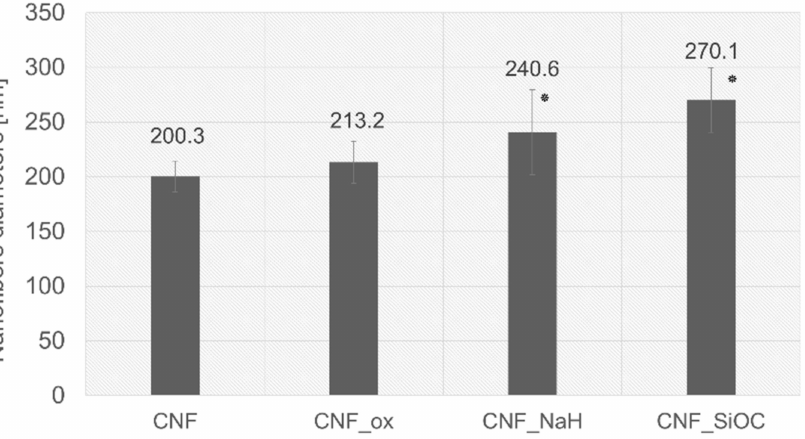
Figure 2. Comparison of mean values of nanofiber diameters, *—result statistically different from CNF ( p < 0.05) based on the Mann–Whitney U test.